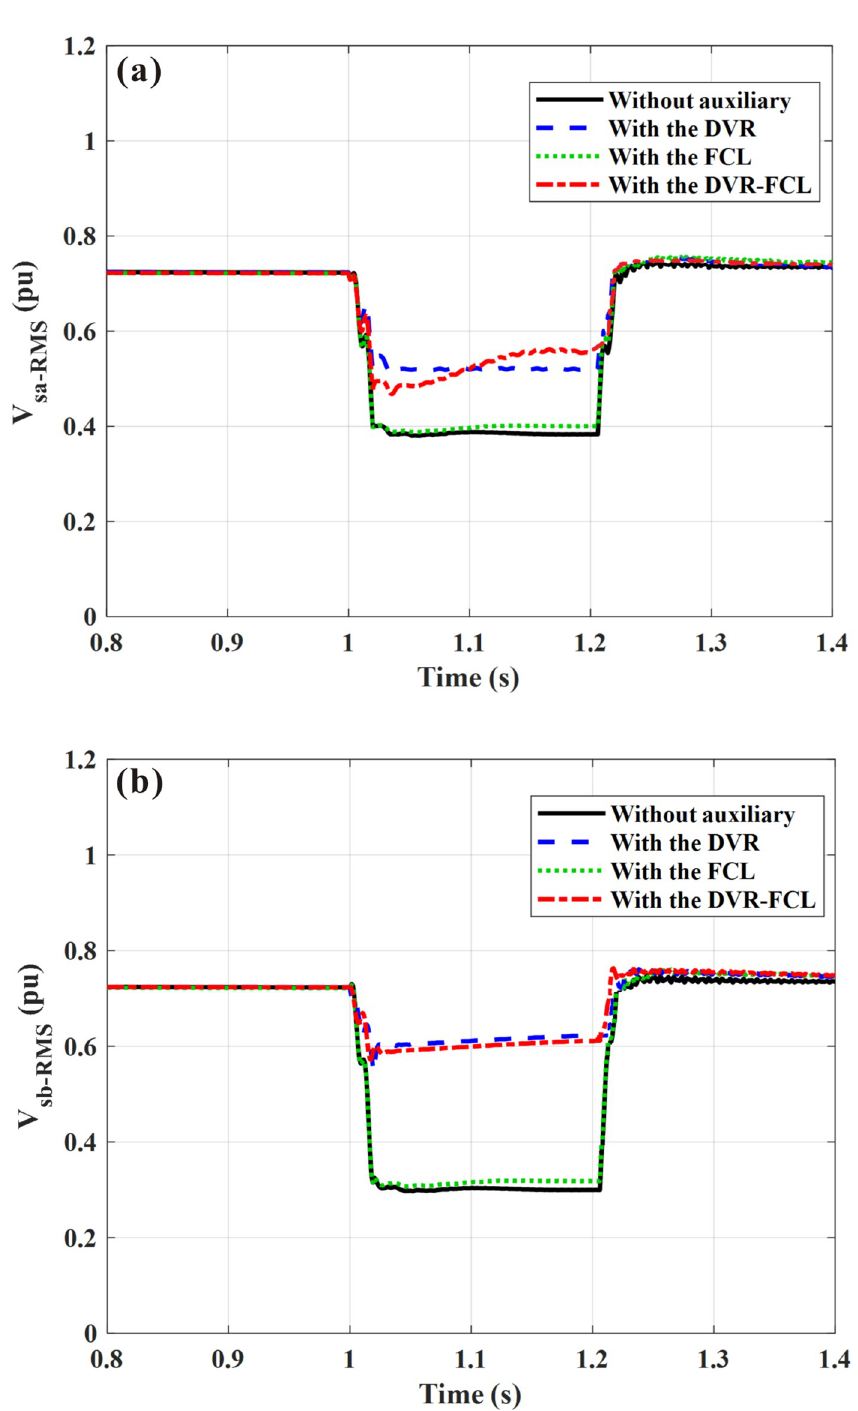
Fig 14. RMS value of the DFIG terminal voltage subject to the asymmetrical fault. (a) phase-A voltage, (b) phase-B voltage.